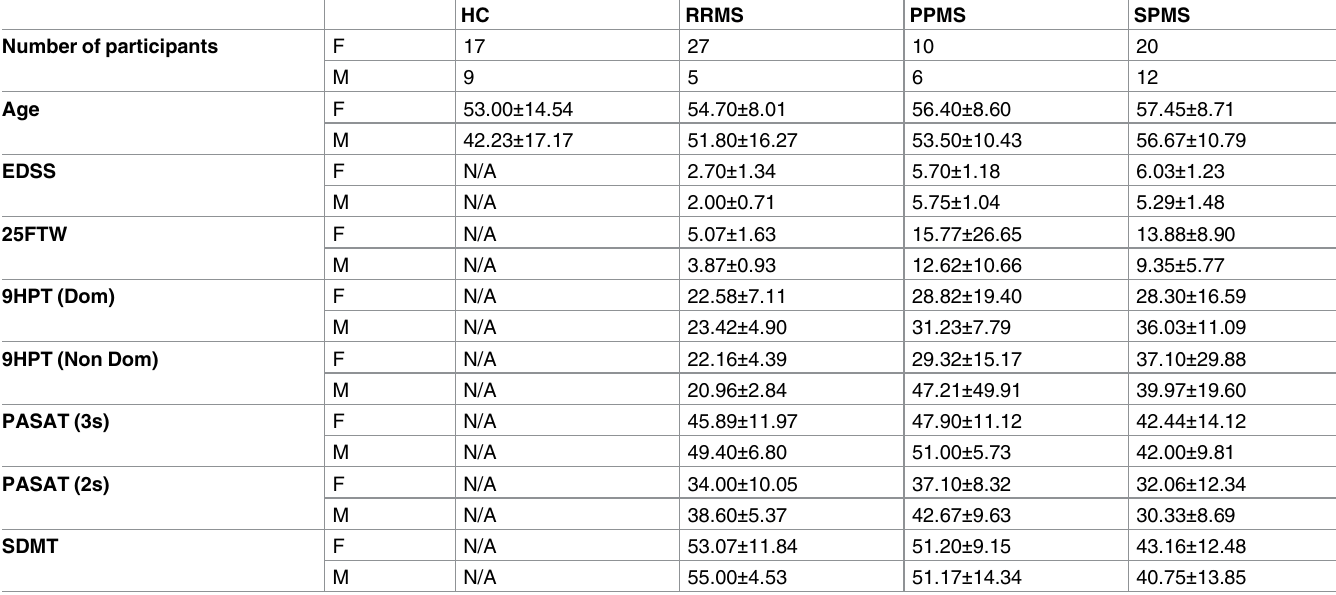
Table 1. Participant characteristics.